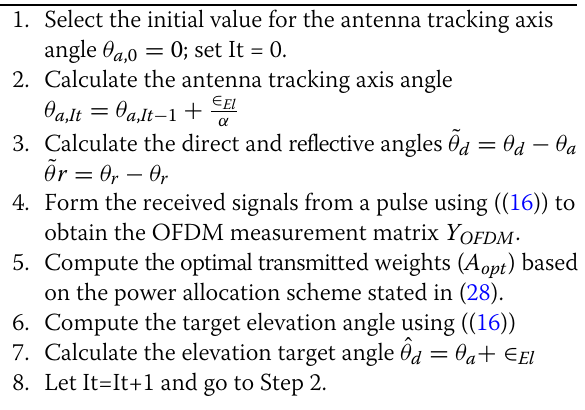
Algorithm 1: Procedure of angle tracking for low- angle